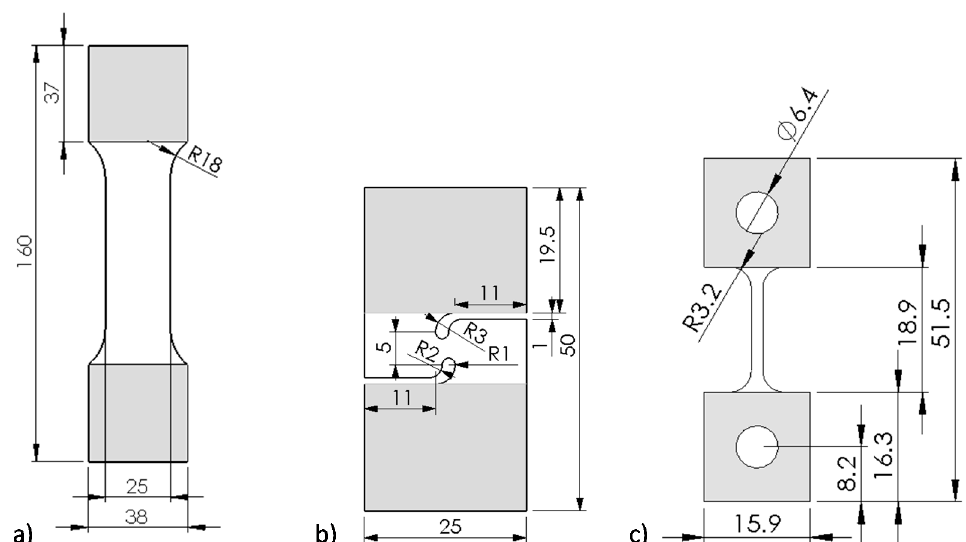
Figure 1. Geometries utilized to conduct tensile tests ( a ), simple shear tests [17] ( b ), and intermediate and high-rate tensile tests [18] ( c ). Note that all units are in mm and that the shaded area corresponds to the material section that was clamped during testing. Table 1. Settings related to data/image acquisition and DIC for the 590R 1 , DP980 2 , 3rd Gen 980 3 , 3rd Gen 1180 V1 4 , and 3rd Gen 1180 V2 5 . Note that the VSGL was computed from the product of the image resolution, steps size, and strain filter. Test